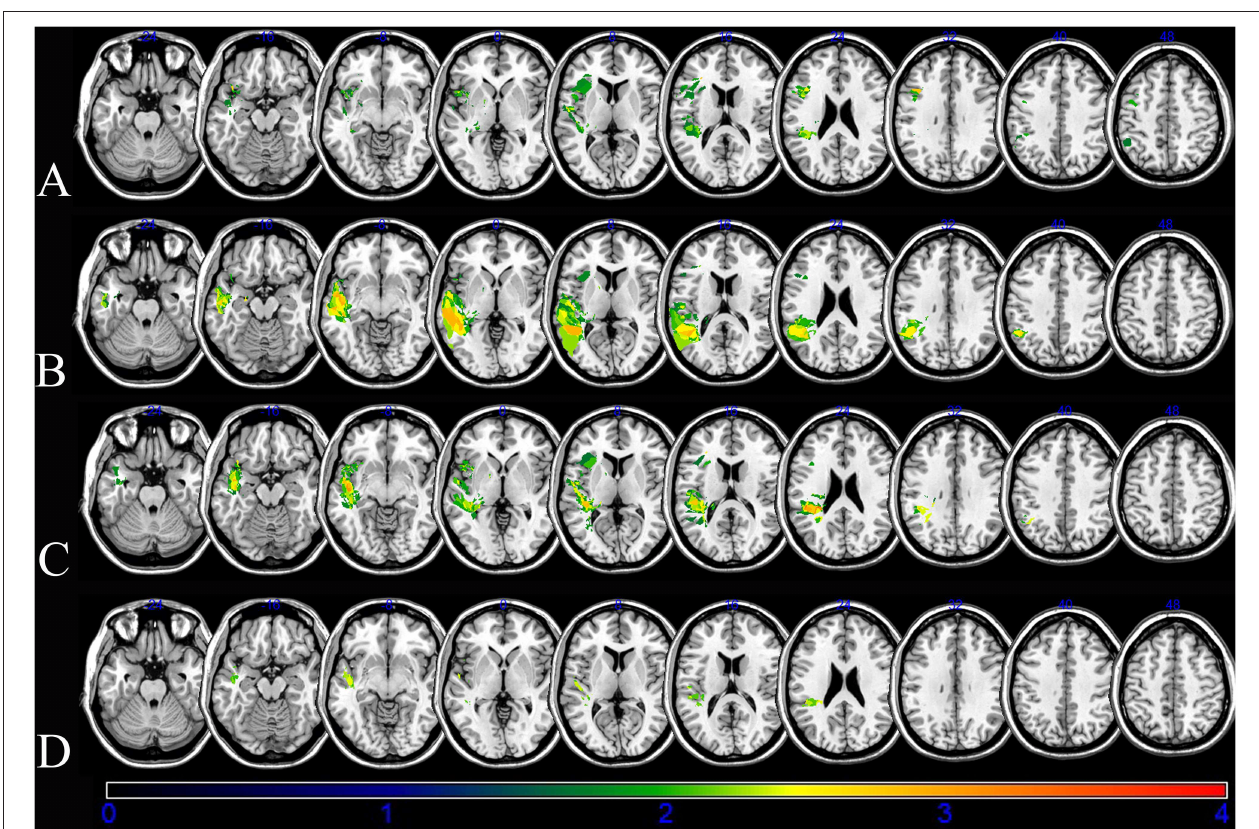
FIGURE 3 | Voxel-based lesion-symptom mapping (VLSM) of the language deficits after the non-parametric Brunner–Munzel statistical analysis. The color scale indicates Brunner–Munzel rank order z statistics. Only voxels significant at p < 0.05 are shown. The maximum range of the z score was set at 4, which was the maximum brightness. (A) VLSM for fluency with a minimum z score of 2.32076. (B) VLSM for comprehension with a minimum Z score of 2.50055. (C) VLSM for naming with a minimum Z score of 2.38888. (D) VLSM for repetition with a minimum Z score of 3.19465.